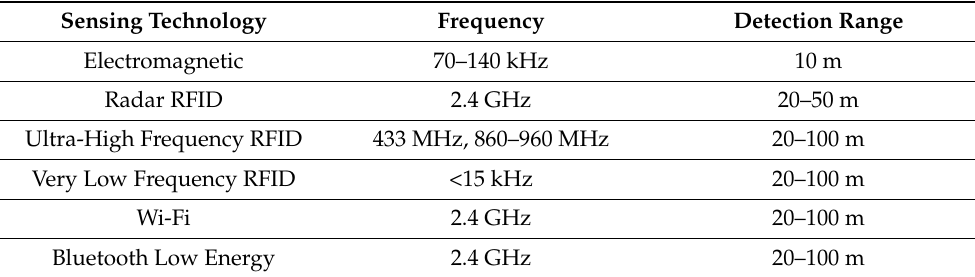
Table 1. Characteristics of sensor technology used for the development of PWSs (modified from